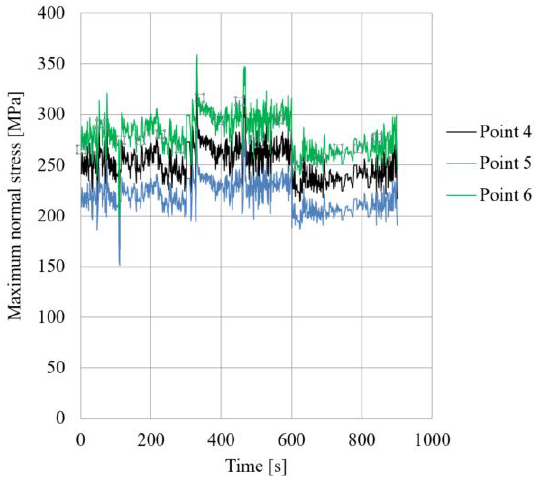
Figure 11. History of maximum normal stress within the base material under dynamic load.